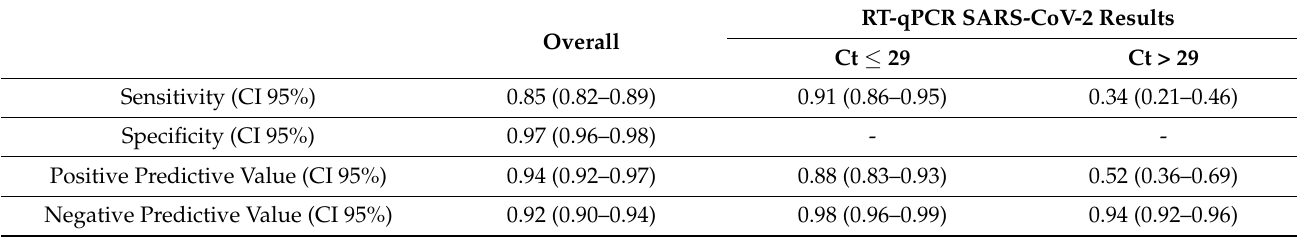
Table 2. Performances of the SARS-CoV-2 antigenic POC test against RT-qPCR